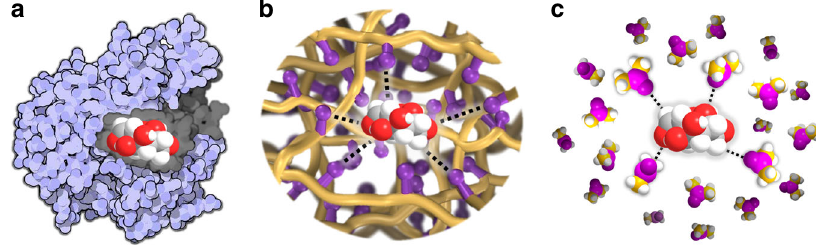
Fig. 1 Schematic illustration of reactant as representative by fructose in various systems. a A fl awlessly engineered space of enzyme, b a microenvironment with solvent-like behavior inspired by nature and solution system, and c solvent containing hydrogen bond